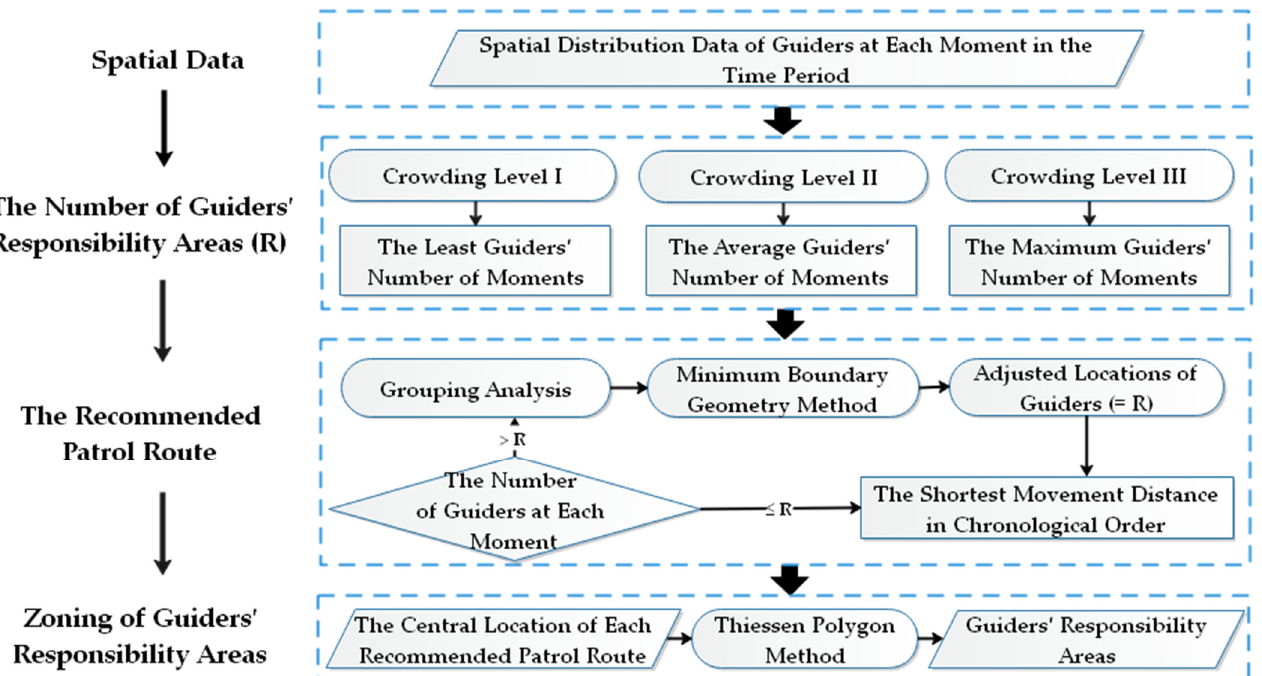
Figure 6. Flow chart of the zoning of guiders’ responsibility areas.